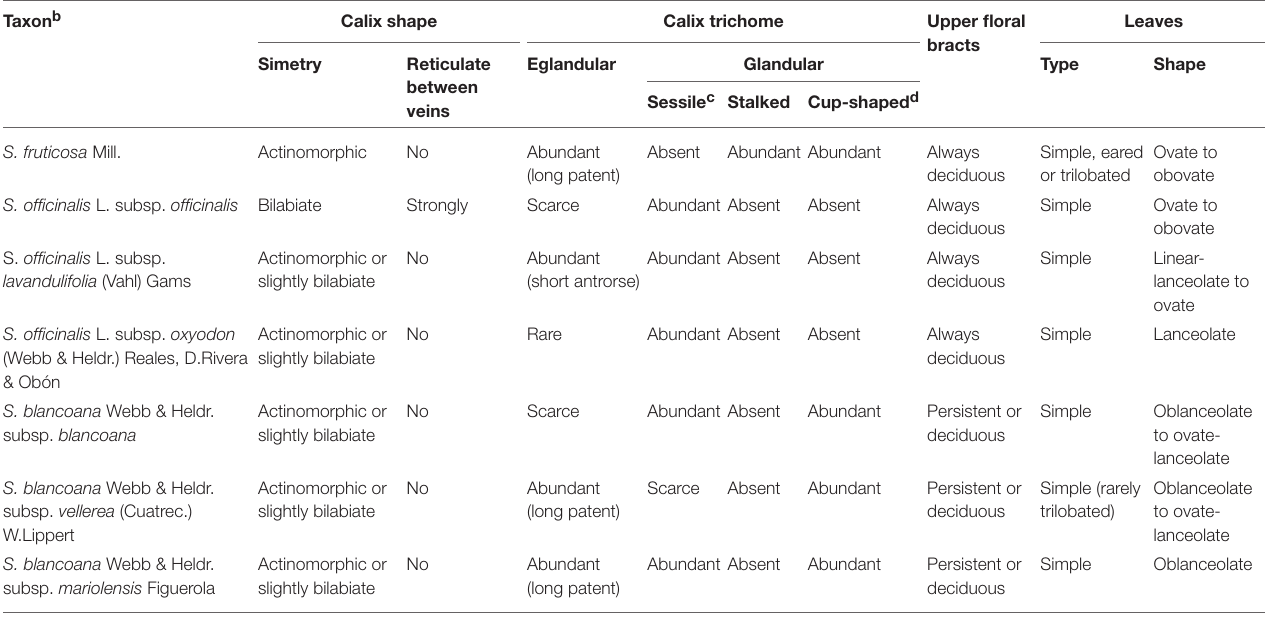
TABLE 3 | Main macro and micromorphological characters for identification of the aerial parts of some taxa of Salvia traditionally used in the Iberian Peninsula a . Taxon